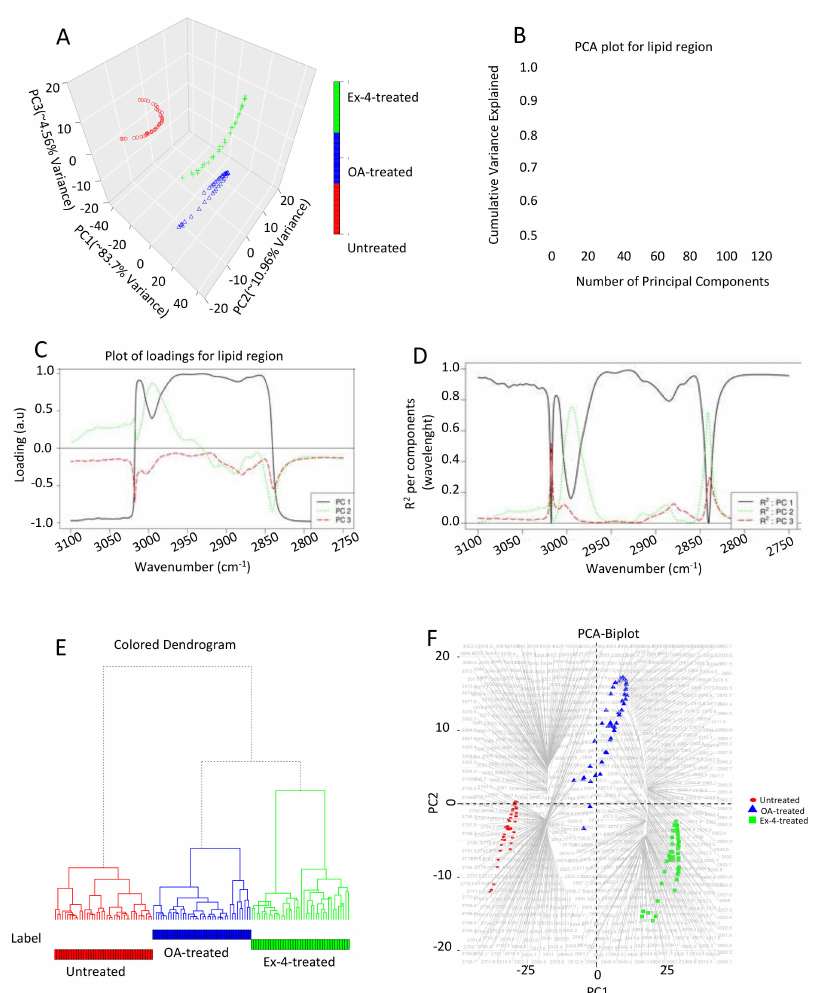
Figure 6. Chemometric analysis of FTIR experimental data on the lipid region (3100–2750 cm − 1 ). ( A ) PCA score plot. ( B ) Amount of variance captured by PCs. ( C ) Loading plots for the spectral data. ( D ) Squared correlation for the first three PCs for the spectral collection. ( E ) Hierarchical clustering of the spectra for the different experimental samples. ( F ) PCA biplot explaining which wavenumbers are associated with which treatment samples. Each treatment condition was repeated three times. The FTIR spectra analyzed were 70, 80, and 80 for the untreated, steatotic, and Ex-4-treated HepG2 cells,